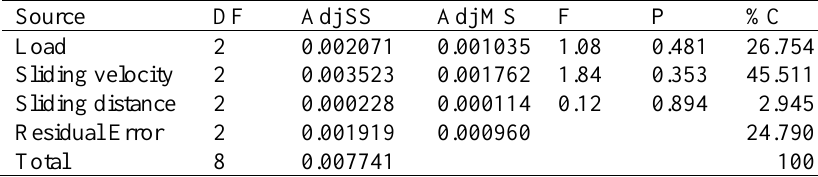
Table 11. Results of analysis of variance on grey relational grade.